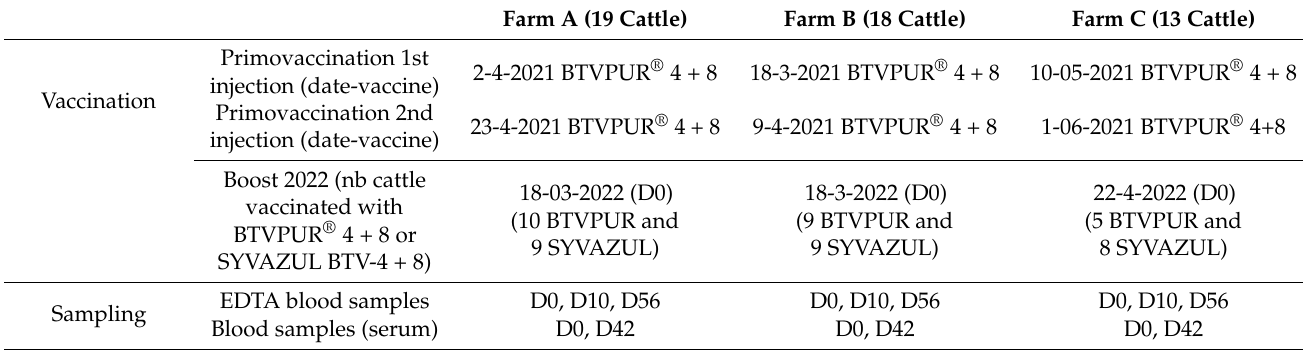
Table 1. Study design (vaccinal interventions and sampling). Farm A (19 Cattle) Farm B (18 Cattle) Farm C (13